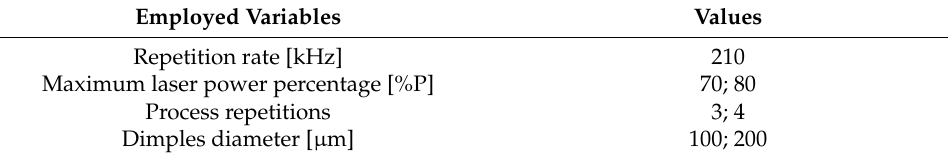
Table 4. Fixed experimental conditions for the laser configuration.